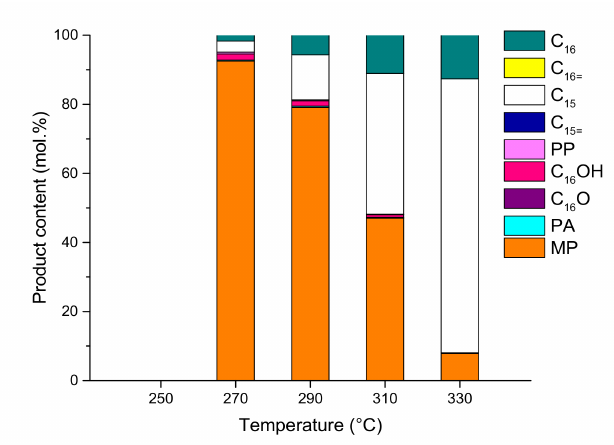
Figure 5. Effect of temperature on the composition of the liquid feed obtained in the HDO of methyl palmitate over Ni 2 P/SiO 2 –SiC system. Reaction conditions: P H WHSV—5 h − 1 .